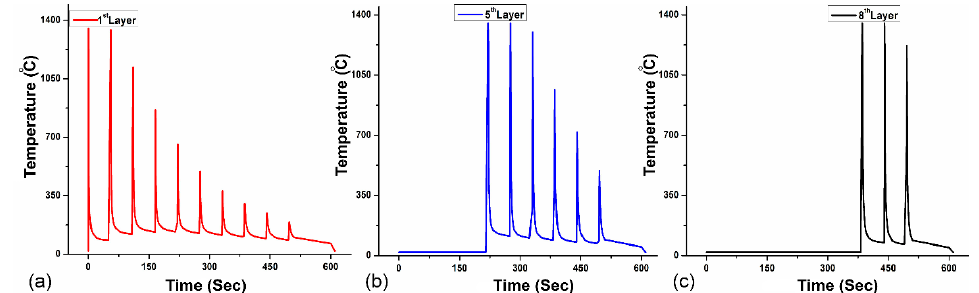
Figure 10. Temperature pro fi le for subsequent layers: ( a ) fi rst layer, ( b ) fi fth layer, ( c ) eighth layer.